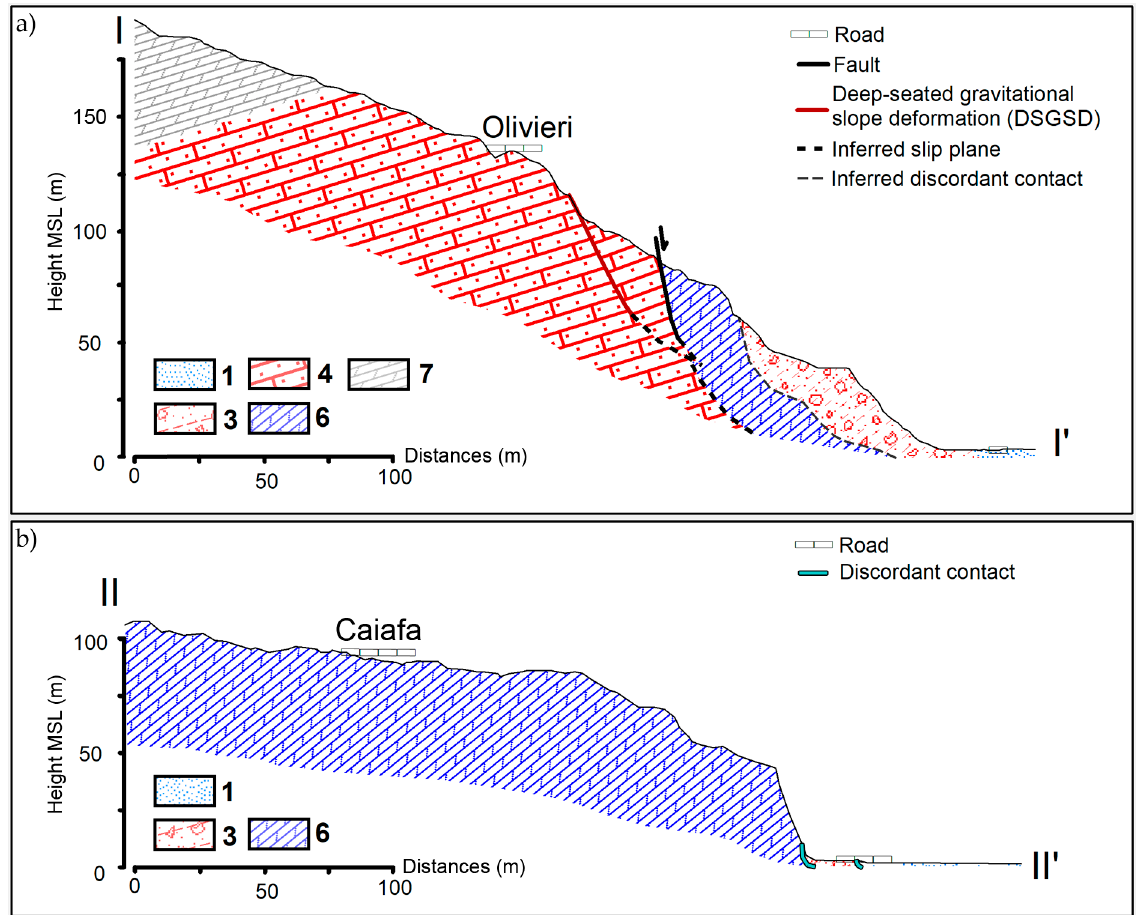
Figure 4. Geological cross sections: ( a ) profile intersecting the Olivieri viaduct; ( b ) profile intersecting the Caiafa viaduct. 1. anthropogenic debris and landfills; 3. dense to partially cemented clastic and heterometric deposits, sometimes as stratiform bodies, composed of coarse angular and subangular grains; 4. dolomites and limestones, massive or in medium thin layers; 6. well stratified–massive dolomites, in many layers laminated and 7. dolomite in thin and medium layers, alternating with laminated dolomites.